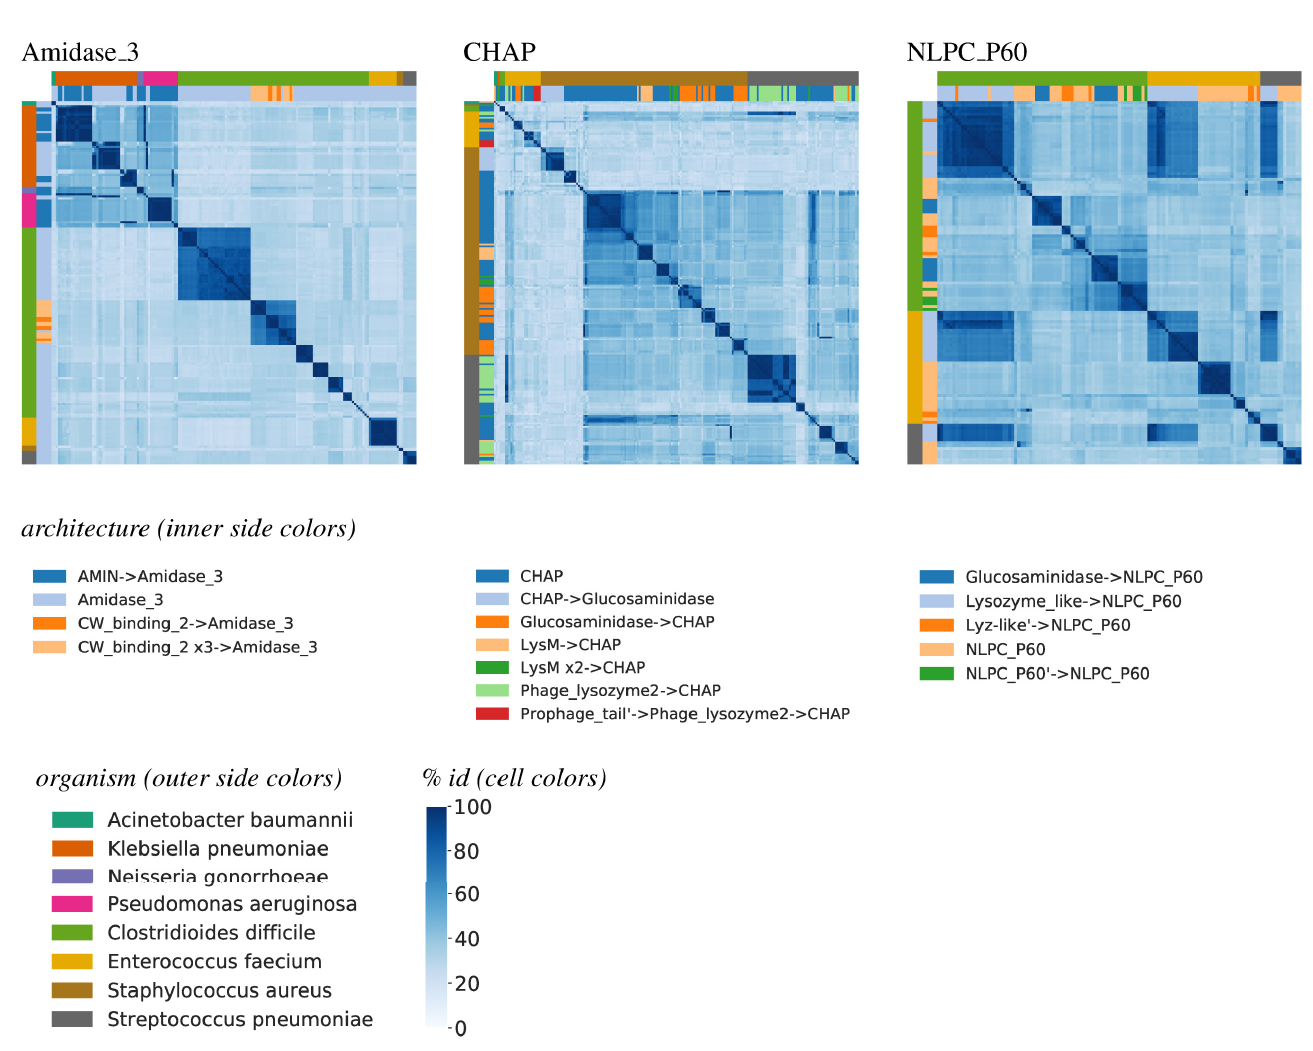
PLOS Computational Biology | https://doi.org/10.1371/journal.pcbi.1008889 April 1,